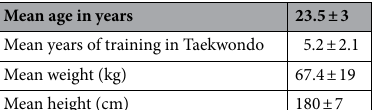
Table 1. Participants’ demographic information (n = 14), Mean ± SEM (standard error of mean).